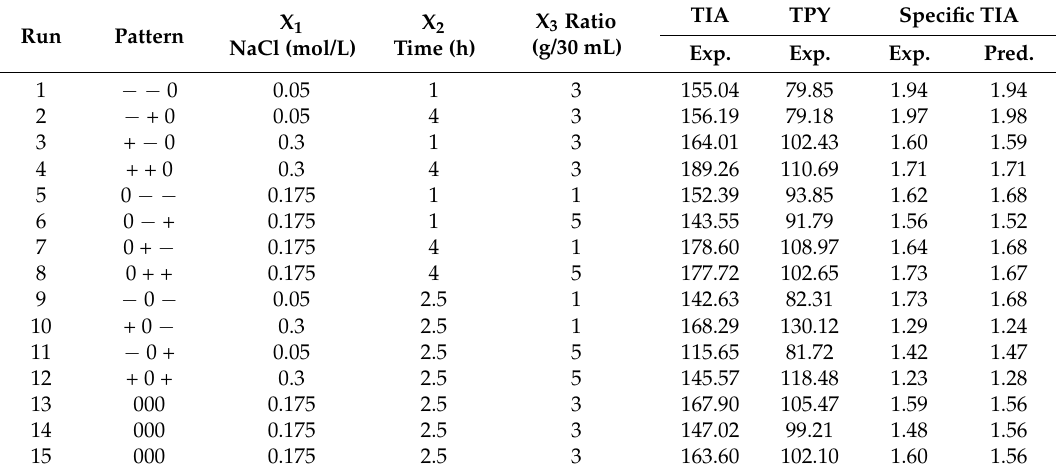
Table 4. The experimental values for trypsin-inhibiting activity (TIA), total protein yield (TPY) and specific TIA and the predicted values for specific TIA for the extracts produced using a 15 run RSM Box–Behnken design.